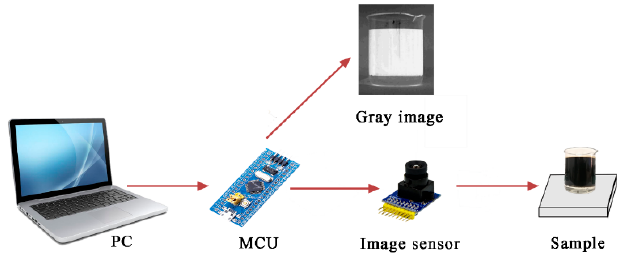
Figure 1. Block diagram of water content of crude oil measurement based on computer vision.